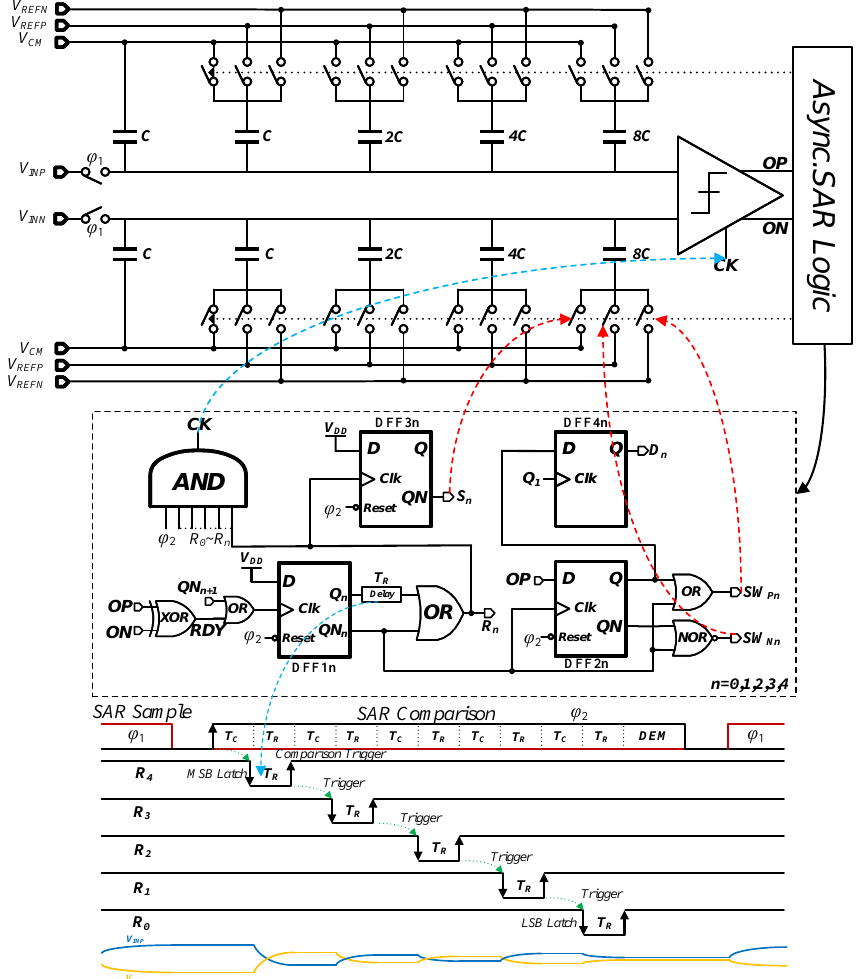
Figure 11. Schematic of 5-bit asynchronous SAR ADC and asynchronous logic, timing